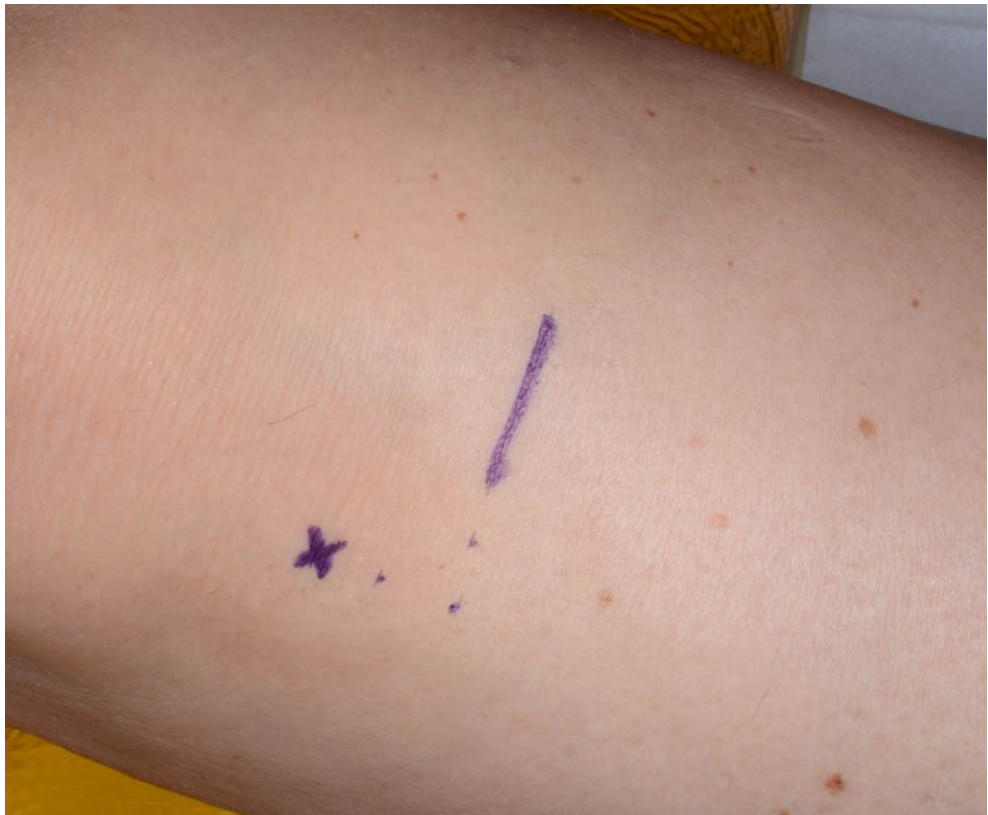
Figure 1. Incision line for the medial approach to the proximal tibia. Legend: “x” indicates the middle of the tibial tuberosity; the dots are marked 1 cm apart one from another.